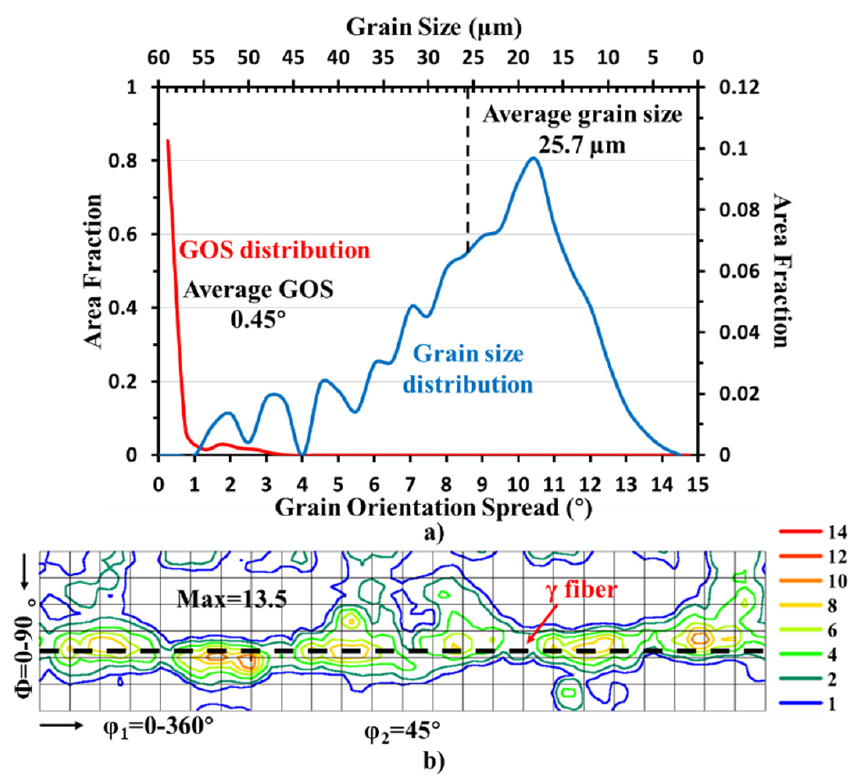
Figure 1. ( a ) GOS and grain size distributions of initial material. ( b ) Orientation distribution function (ODF) section plot ( ϕ 2 = 45 ◦ ) for initial material, and the dotted black line shows the ideal position of γ fiber.